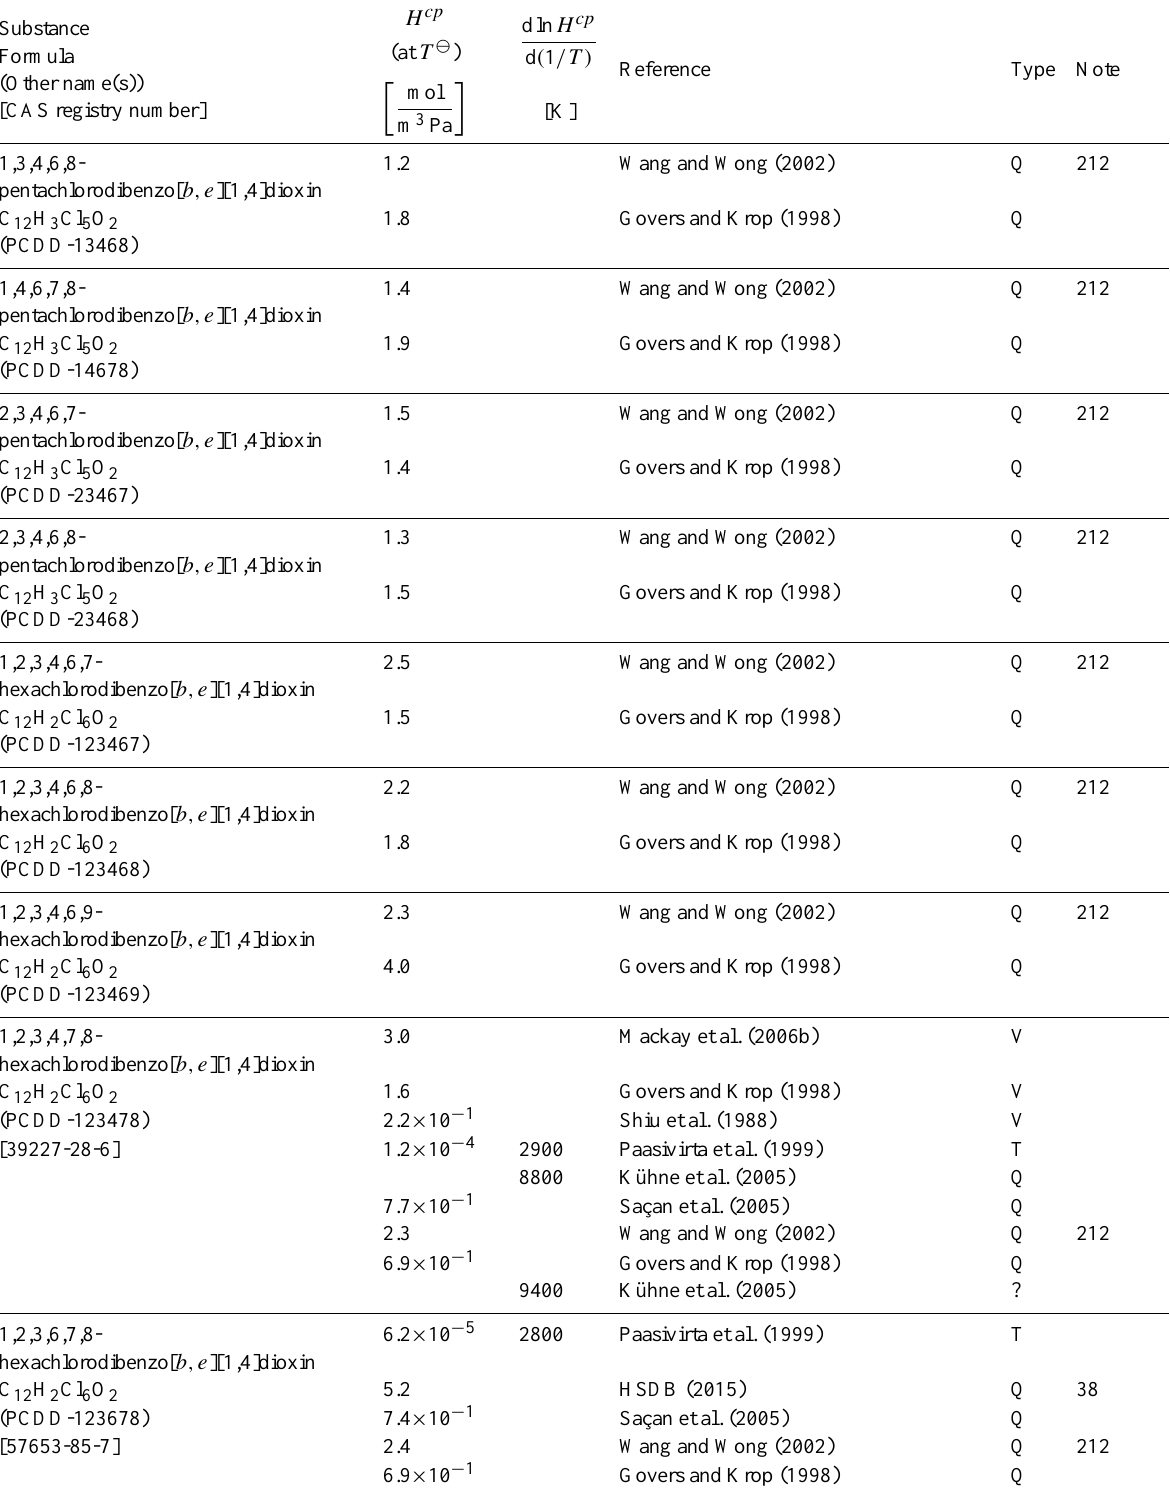
Table 6: Henry’s law constants for water as solvent